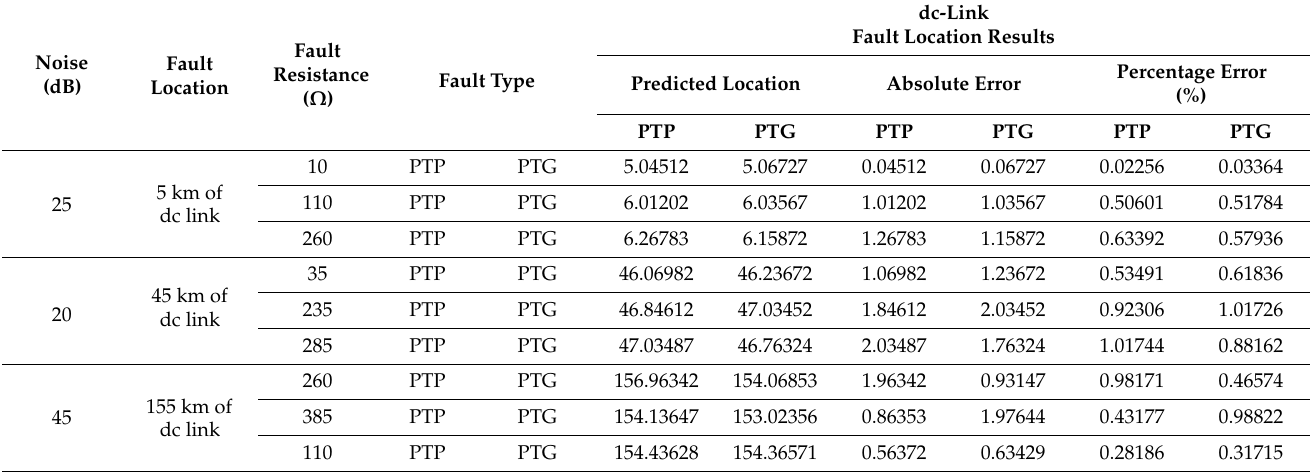
Table 10. Results under the different noisy event.